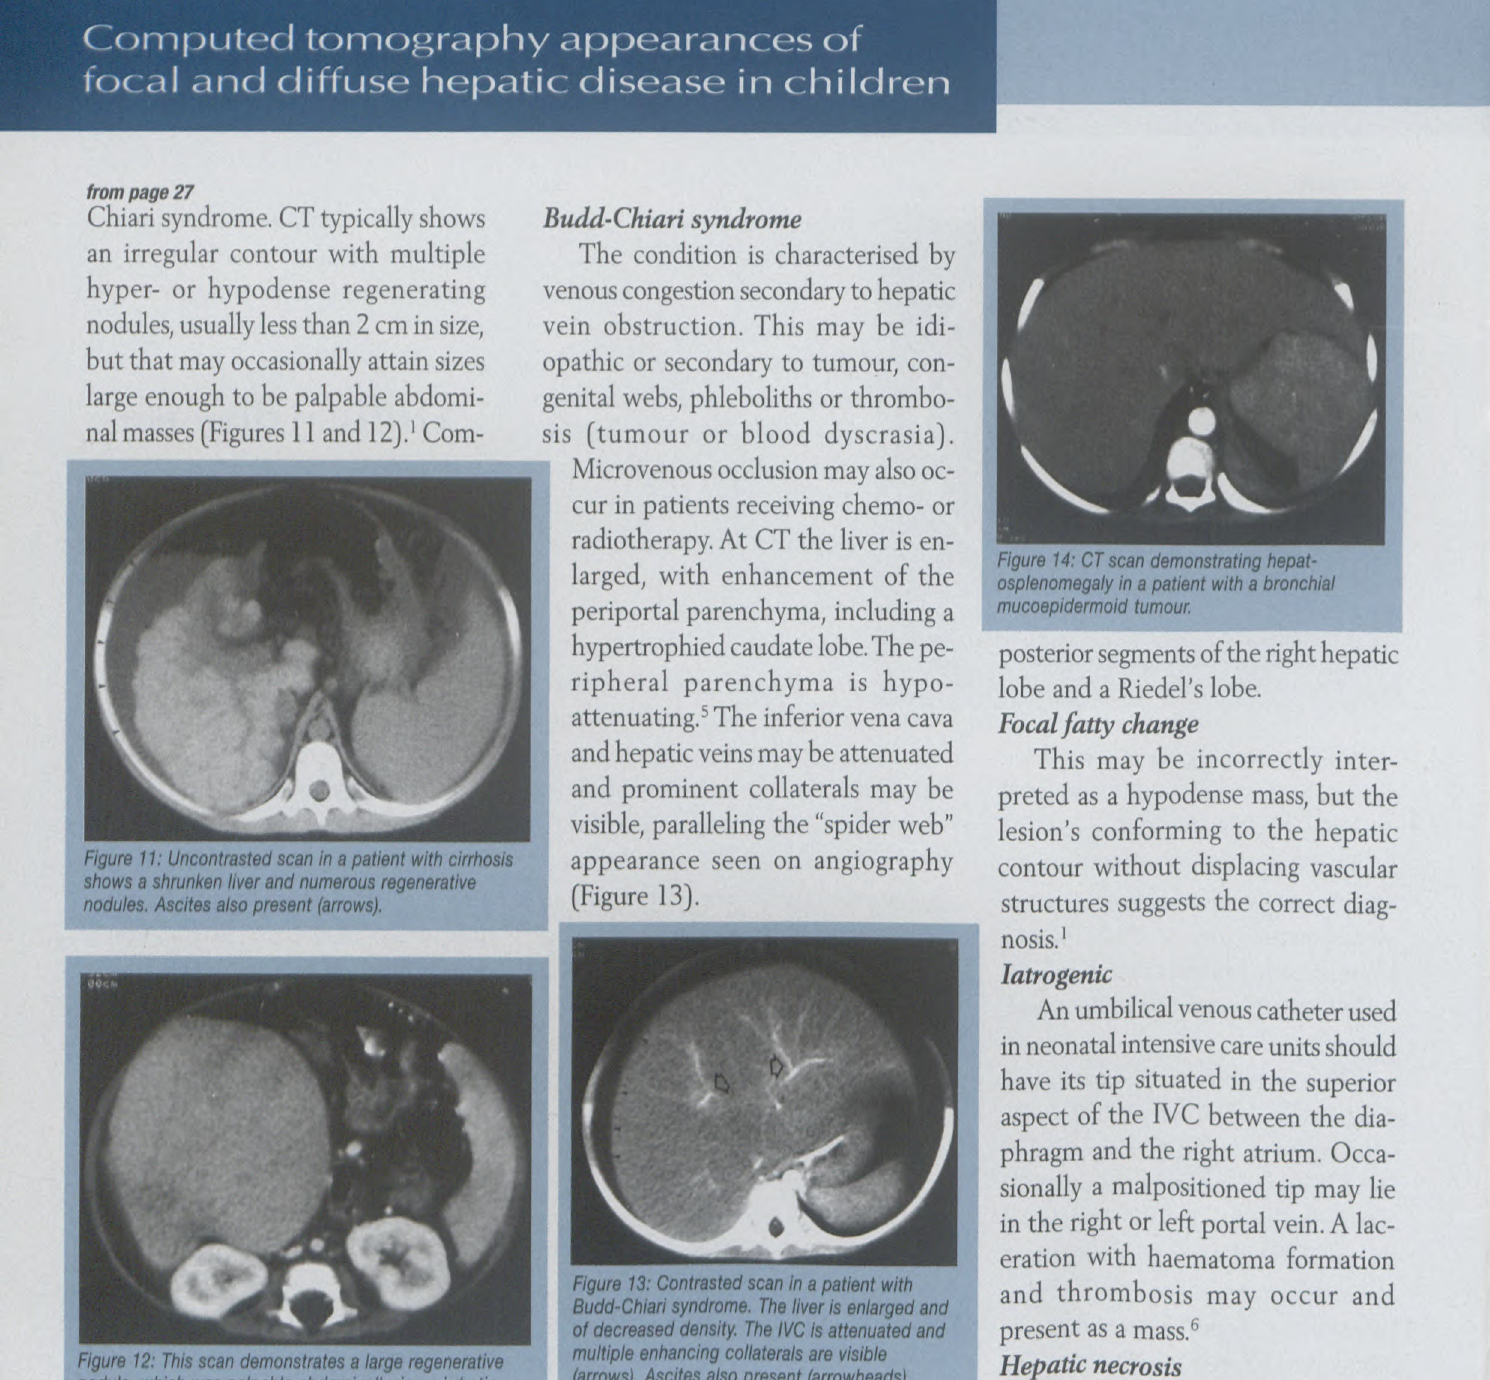
Figure 12: This scan demonsirates a large regenerative nodule. which was palpable abdomInally, in a cirrhotic patient plications such as fatty infiltration and HCC are also demonstrated at CT.